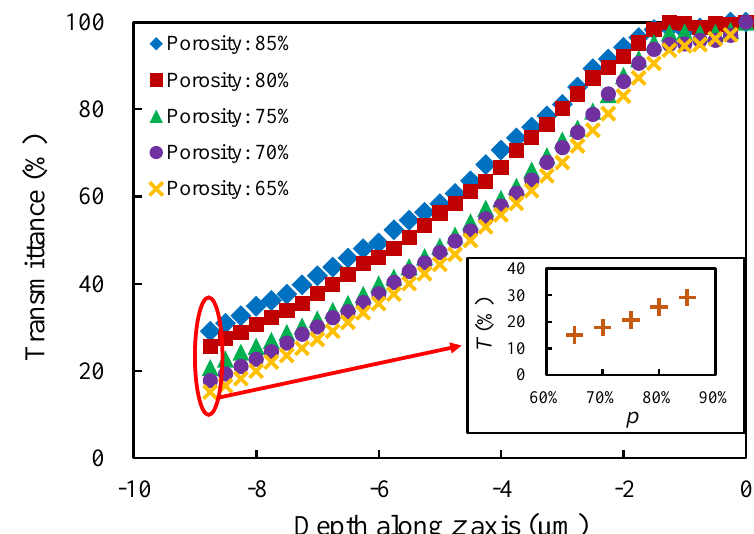
Figure 11. Evolution of the transmittance with the depth along z axis for the models with different